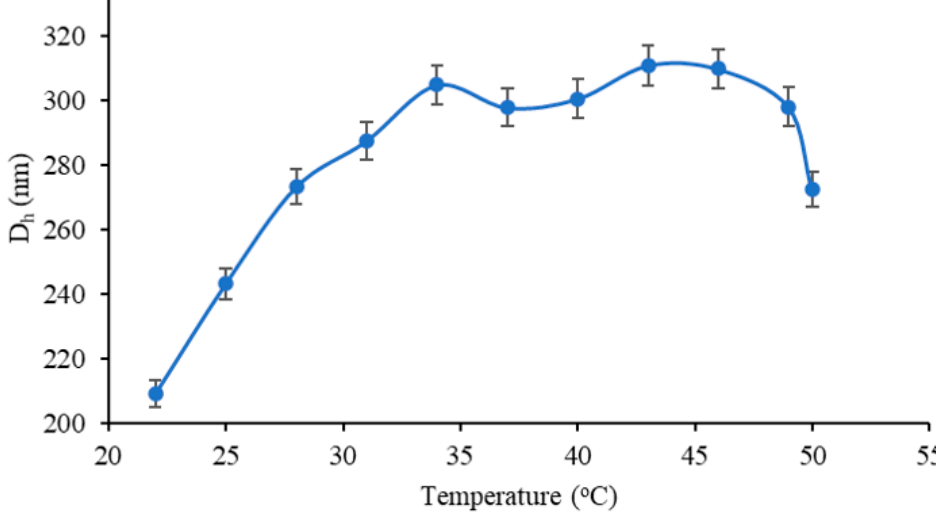
Figure 10. Variation of BSA / MAC nanogel D h with temperature.